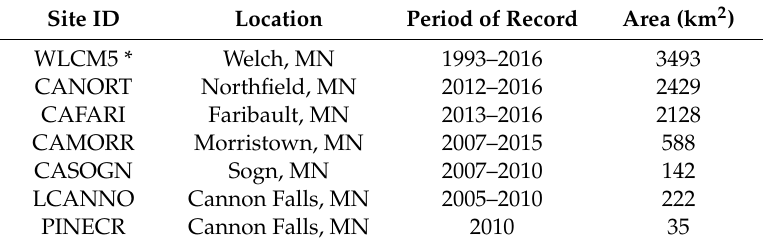
Table 3. Cannon River basin and subbasins gage sites. Outlet of the Cannon River watershed, denoted with “*”, has United States Geological Survey station ID 05355200 and US National Weather Service ID